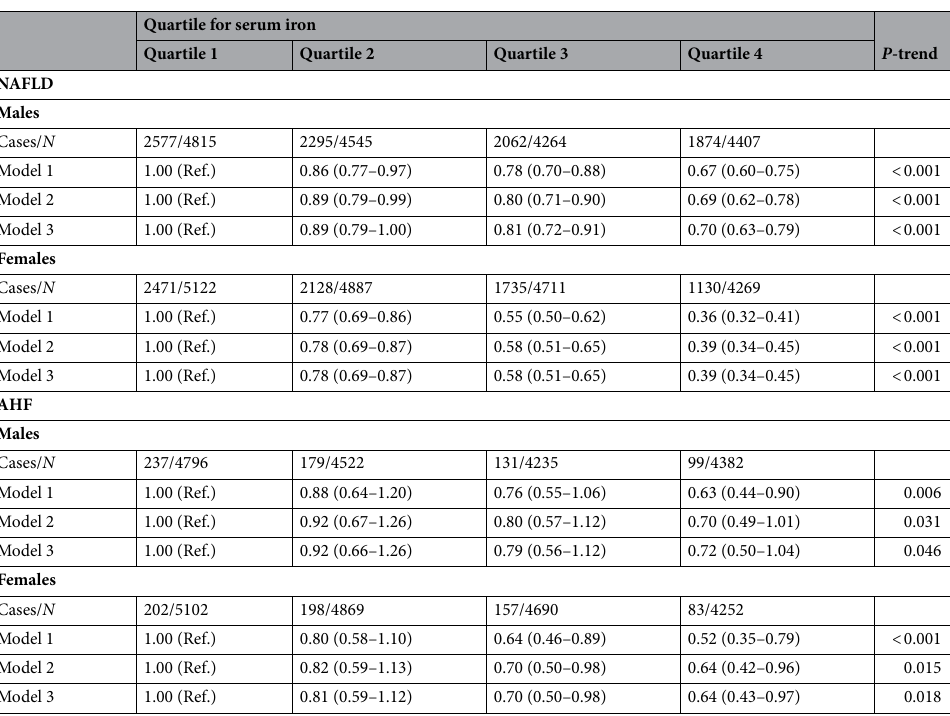
Table 5. Survey weighted odds ratios (95% CI) for association between serum iron and presence of NAFLD or AHF. Model 1: age (years), race (Mexican American, other Hispanic, non-Hispanic white, non-Hispanic black, other race), marital status (married or cohabitation, widowed or separated, never married), education level (less than 12th grade, high school or equivalent, college graduate or above), family poverty income ratio; Model 2: model 1 + smoking status (never, ever, current), alcohol intake (drinkers/week), leisure activity (MET- min/day), total energy intake (kcal/day), healthy eating index-2015; Model 3: model 2 + lead (μg/dL),